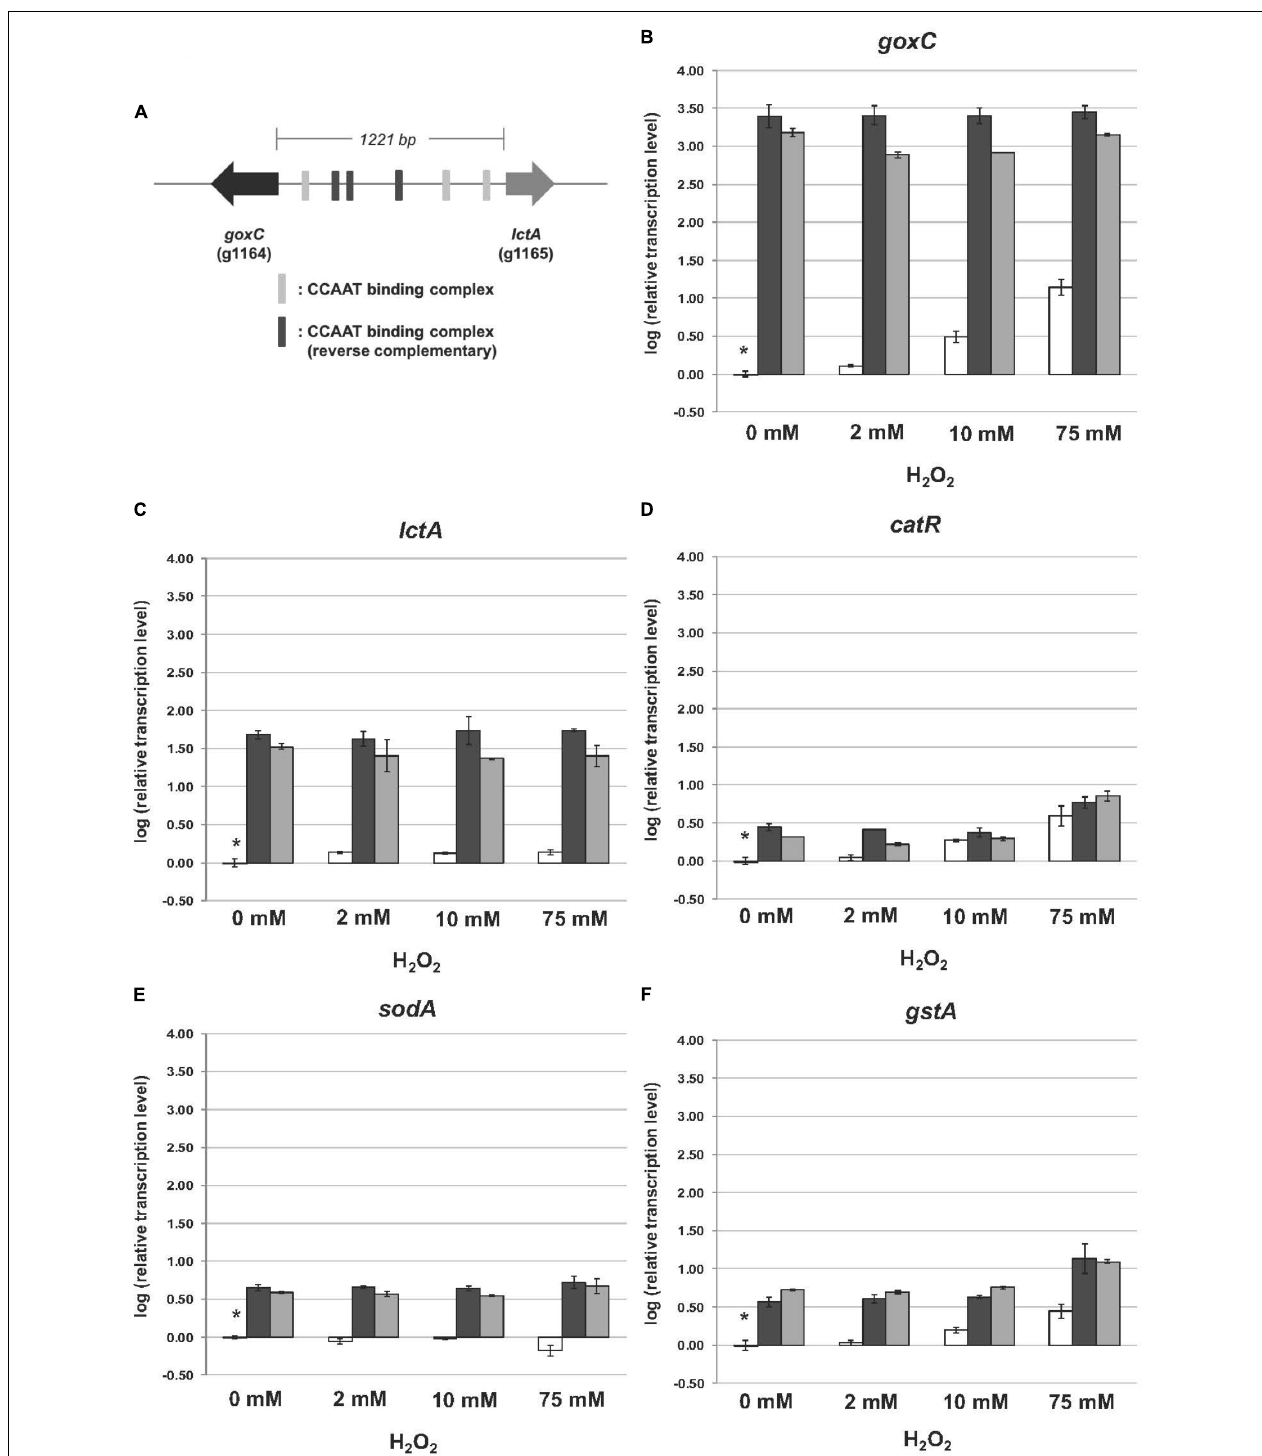
FIGURE 5 | Expression of the glucose oxidase, lactonase, catalase, superoxide dismutase, and glutathione-S-transferase encoding genes upon hydrogen peroxide addition. Samples were taken 3 h after mycelium transfer to minimal medium with different concentrations of hydrogen peroxide (0–75 mM). (A) Genomic organization of goxC and lctA on chromosome II. The six putative CCAAT boxes are indicated in gray. (B–F) Expression analysis performed by RT-qPCR with the primers specific for goxC (B) , lctA (C) , catR (D) , sodA (E) , and gstA (F) gene. White bars represent expression levels obtained in strain N402, black bars in (cid:49) trxR -1A and gray bars in (cid:49) trxR -3A. Normalization of the expression data was done using the histone 4-like gene transcript. Results were calculated as relative transcript ratio in logarithmic scale (log10) with means of two biological replicates. Asterisks represents transcript level of the reference sample.